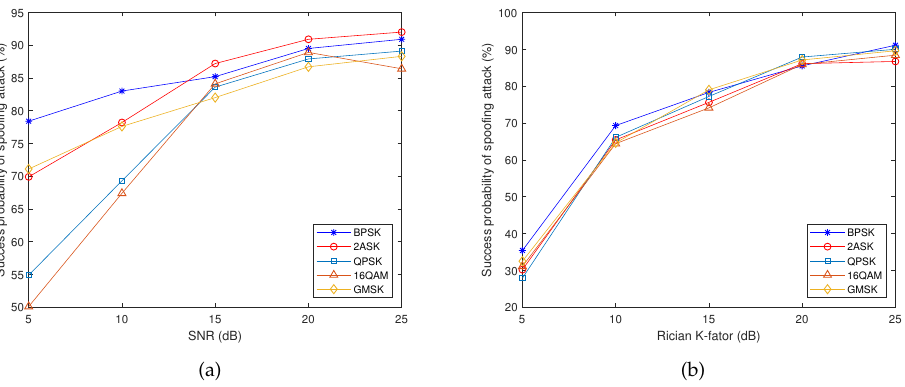
Figure 10. The success probability of spoofing attack versus ( a ) SNR and ( b ) Rician K -factor for multiple modulation